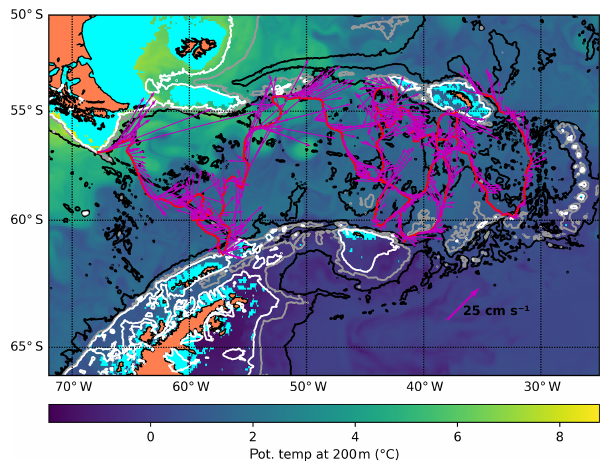
Figure 7. Slow glider trajectory in the Drake Passage, launched off the tip of South America (NW corner). Bathymetric contours are at 500, 1500 and 3000m. Mission ends at South Georgia